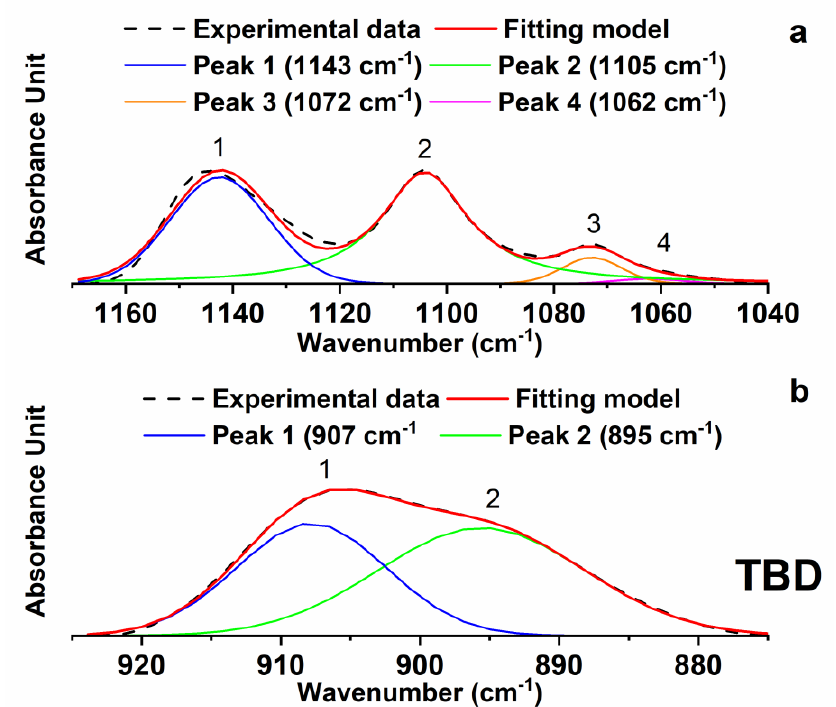
Figure 5. Deconvolution of the FTIR spectrum of the sample TBD collected in the region of the epoxy group ( b ) and the SO 2 stretching signals ( a ).